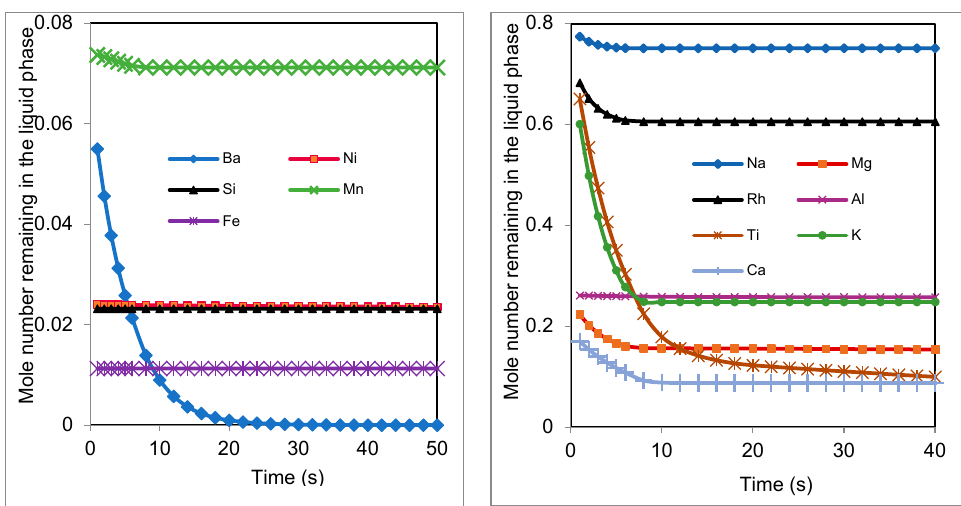
Figure 4. Mass (mg) of elements after each cycle of treatment.